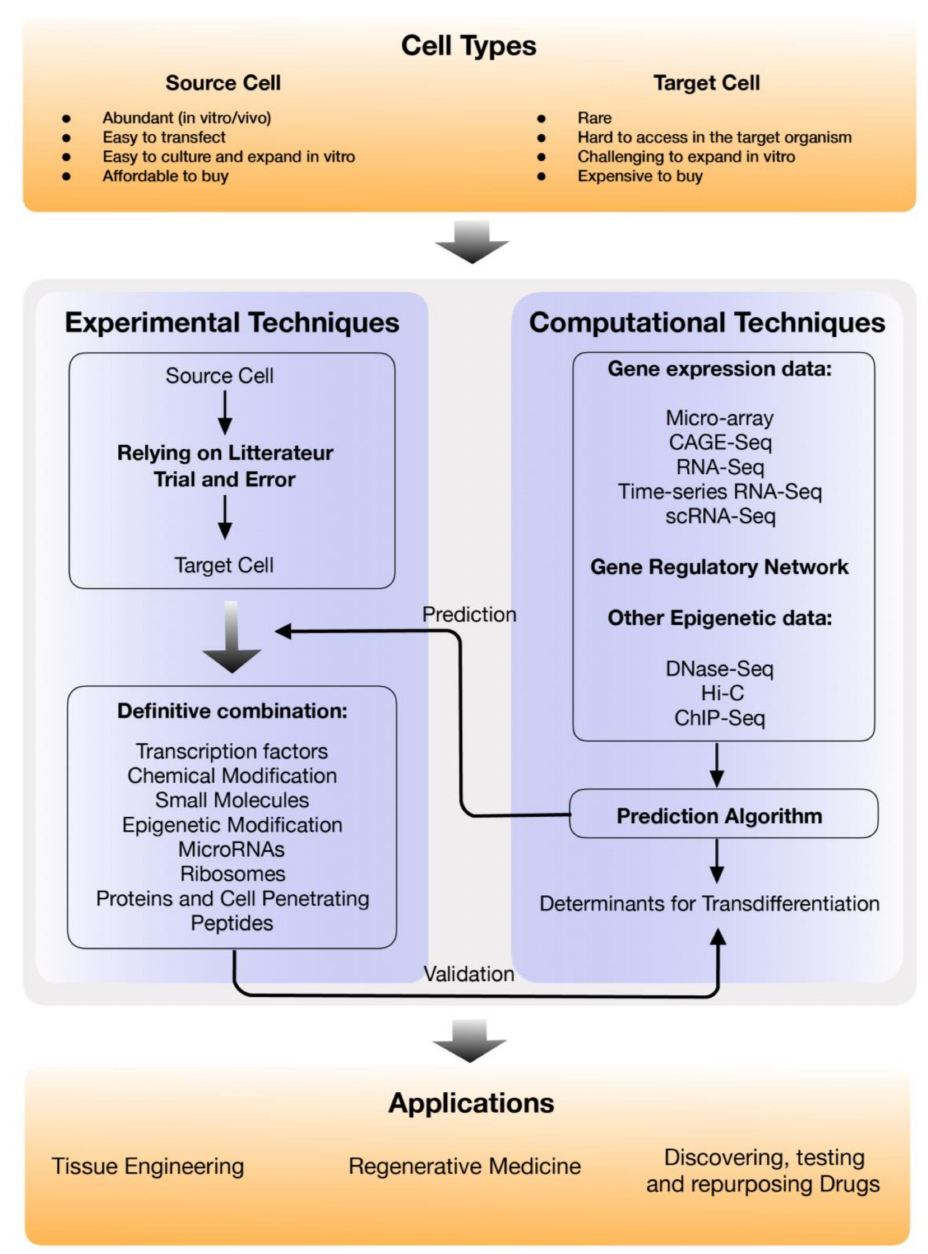
Figure 2. Current and future developments in direct cell reprogramming using experimental